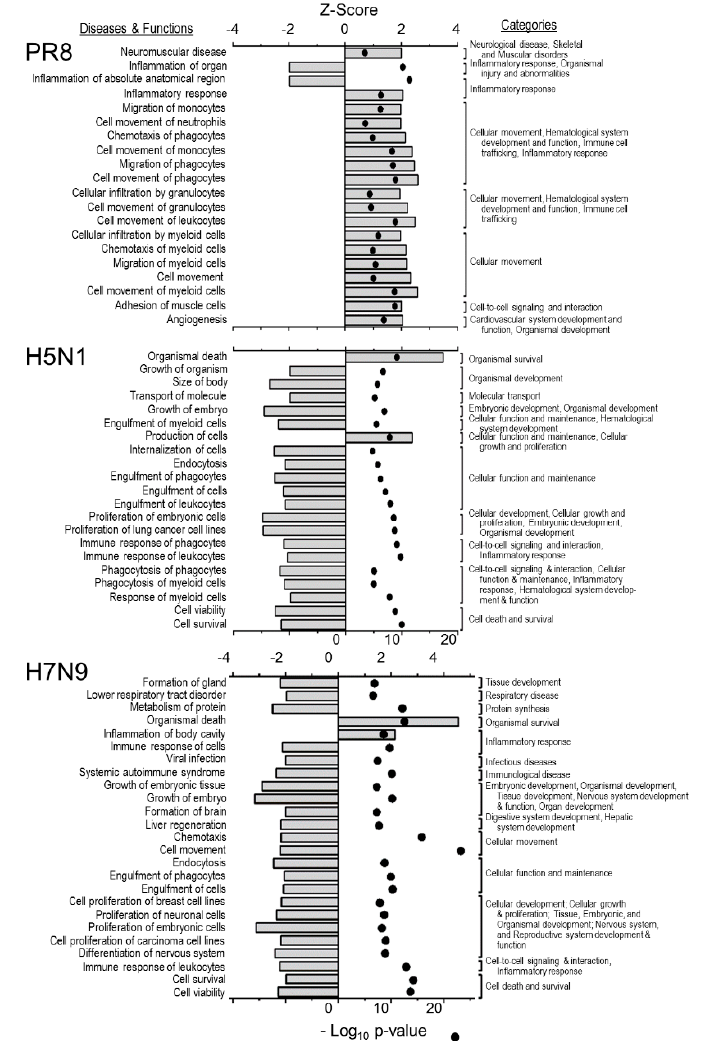
Figure 4. IPA-predicted most affected bio-functions by differentially-expressed proteins by each IAV strain. The default IPA Z-score settings for activation (+1.96 σ ) and inhibition ( − 1.96 σ ) were used. Z-scores are indicated on upper X-axes of each graph and by horizontal bars, and − Log 10 p -values (bottom X-axes) are depicted by • . There were no significantly dysregulated bio-functions by RV733 or pdm09.